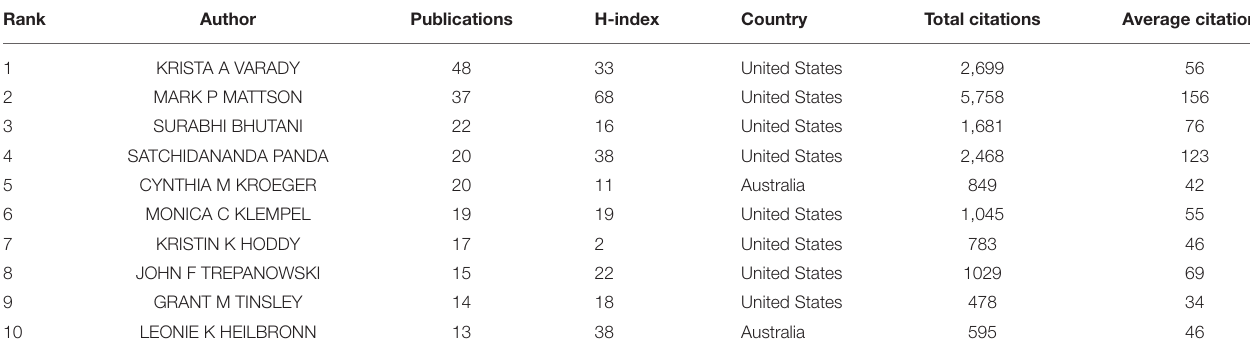
TABLE 3 | Top 10 authors in the field of intermittent fasting in terms of number of published articles. Rank